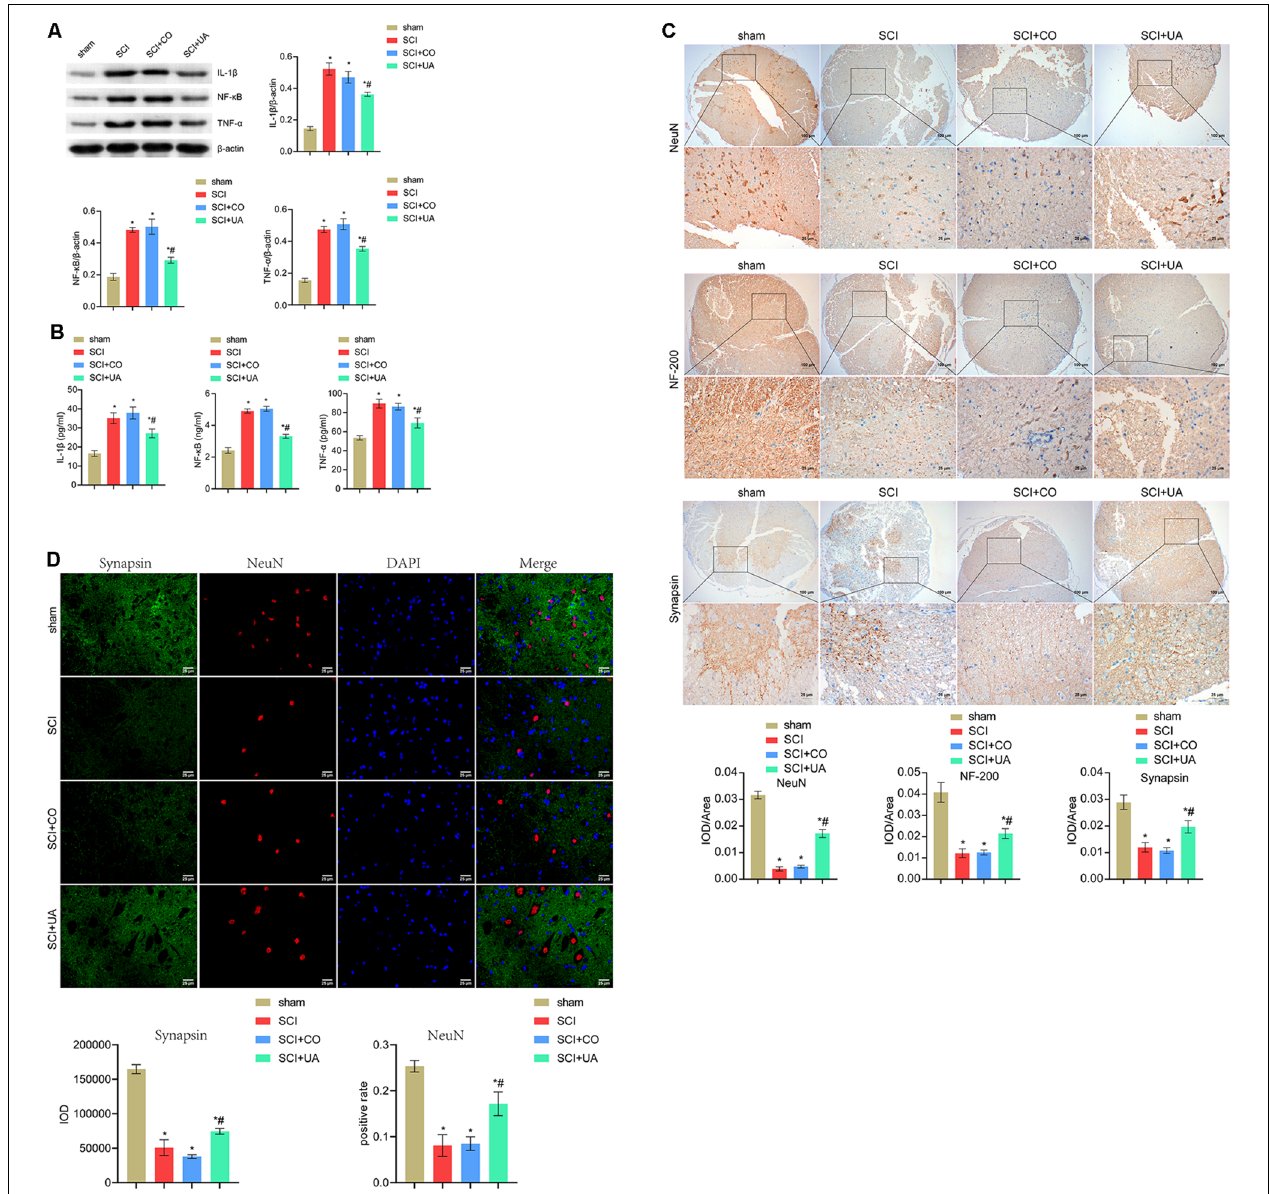
FIGURE 2 | UA inhibited inflammation and promoted neuronal survival and synaptic regeneration. (A) WB was performed to detect the protein expression of IL-1 β , NF- κ B, and TNF- α . (B) The concentration of IL-1 β , NF- κ B, and TNF- α was measured by ELISA. (C) IHC was conducted to analyze the expression of NeuN, NF-200, and synapsin. (D) Immunofluorescence double staining for NeuN and synapsin. Data were expressed as mean ± standard deviation; each experiment was repeated at least three times; n = 3; differences among multiple groups were evaluated by one-way ANOVA followed by a Tukey multiple comparisons posttest. * P < 0.05 vs. the sham group; # P < 0.05 vs. the SCI+CO group; Magnification = 400 times; Scale bar = 25 µ